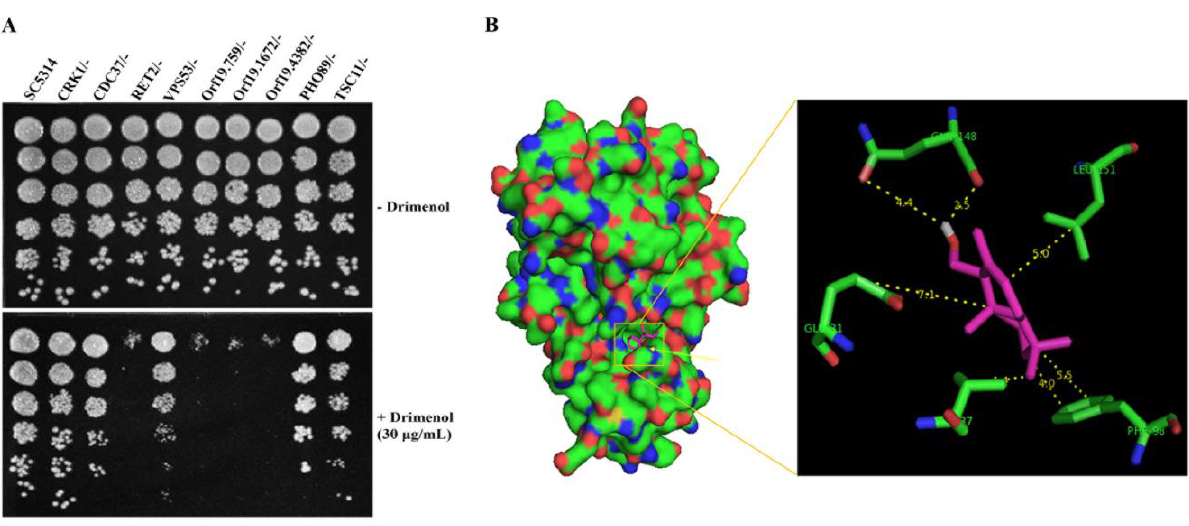
FIGURE 5: Yeast spot assay and molecular docking. (A) Validation of C. albicans Tn-insertion mutant screen data by yeast spot assay. A four- fold serially diluted yeast cultures of indicated C. albicans heterozygous mutants (GRACE) were spot tested on YPD agar containing 1 (30 μ g/ml) or DMSO (- 1 ). Heterozygous mutants ( RET2/-, Orf19.759/-, Orf19.1672/- , and Orf19.4382/- ) directly or indirectly affected by 1 were hypersensitive and showed lack of growth. (B) Molecular docking of drimenol with the C. parvum Crk1 kinase. Molecular docking of 1 with C. parvum Crk1 crystal structure (2QKR-A) was performed using AutoDock Vina